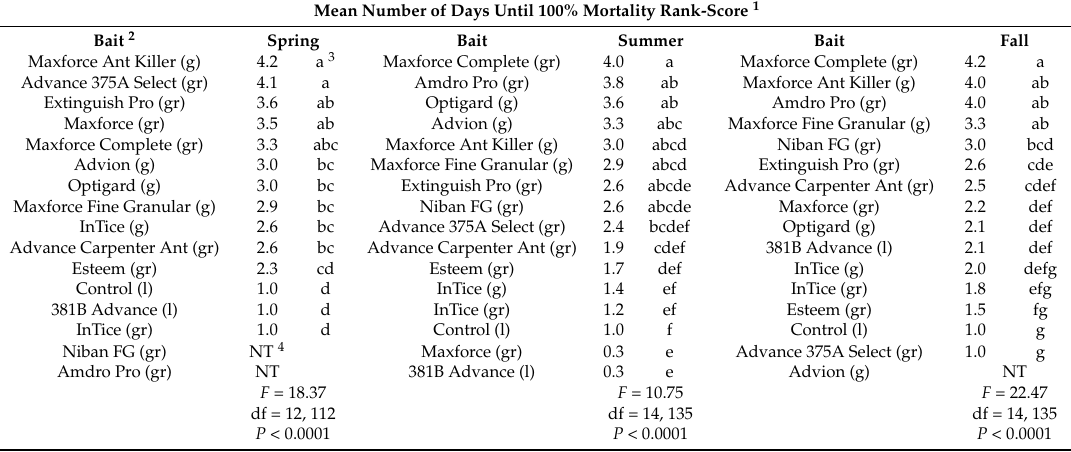
Table 6. Mean ranked days until 100% mortality of Nylanderia fulva after continuous exposure to 15 commercially available baits in no-choice laboratory assays over three seasons (2009–2010) (n = 10 replications for each bait per